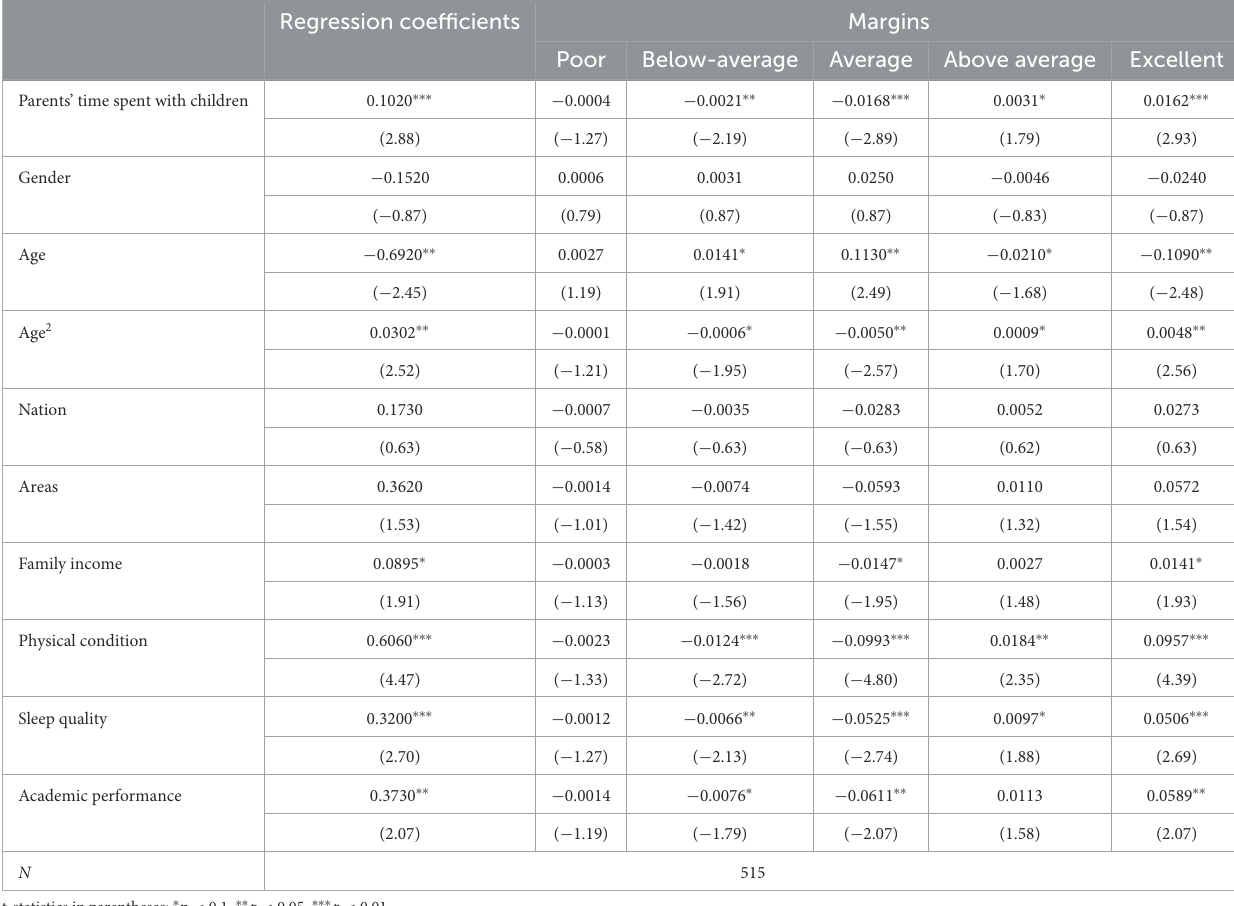
TABLE 4 Results of regressing the time parents spend with children on children’s well-being. Regression coefficients Margins Poor Below-average Average Above average Excellent